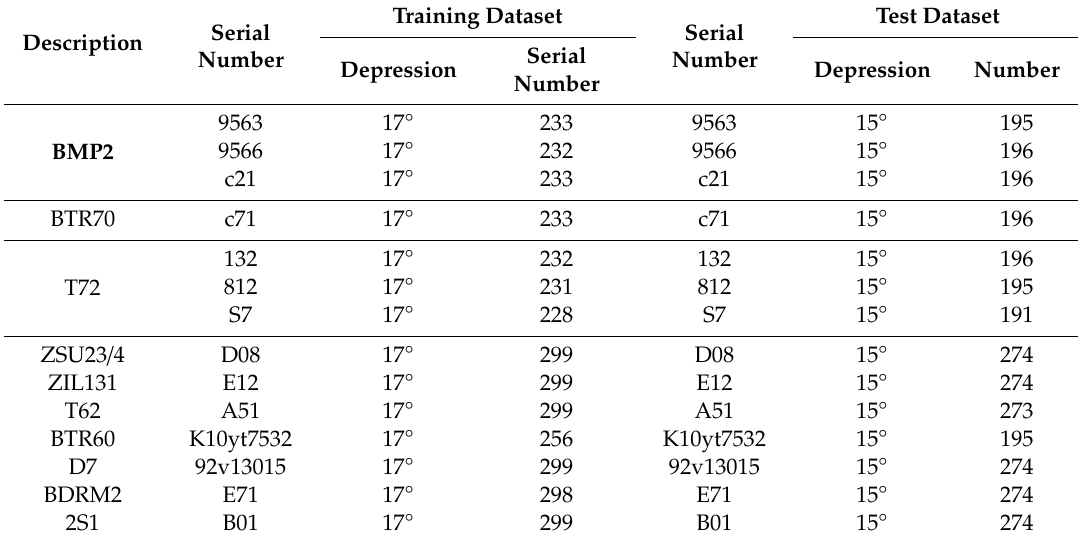
Table 2. The training and test datasets.